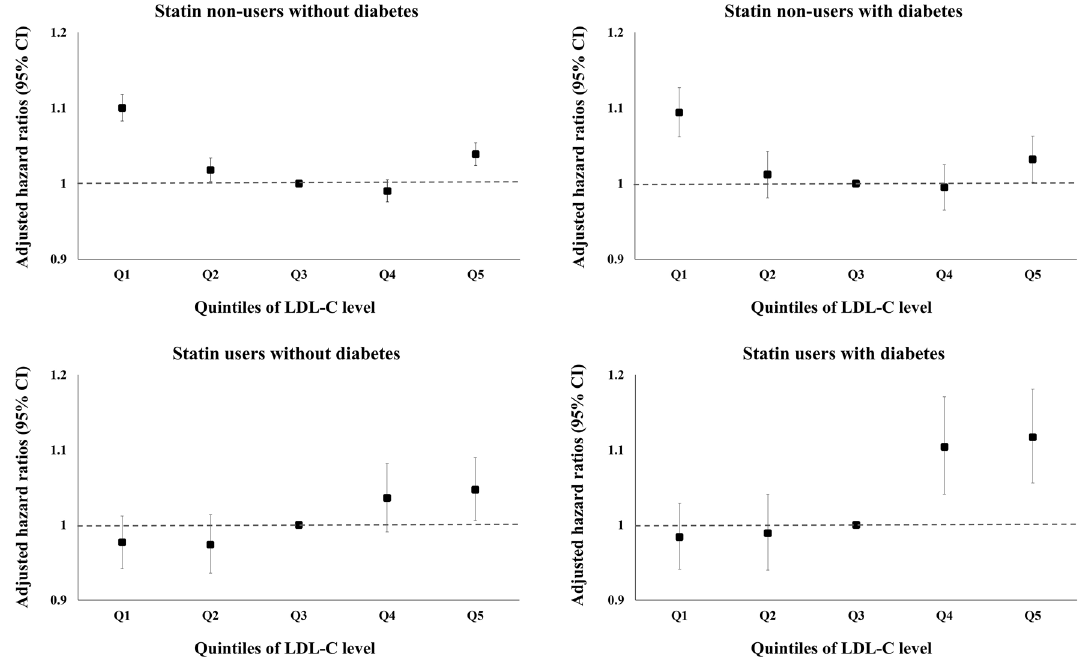
Figure 2. Hazard ratios for the incidence of all-cause dementia according to quintiles of low-density lipoprotein cholesterol levels in groups stratified according to the presence of diabetes and statin use . Adjusted for age, sex, body mass index, hypertension, current smoking status, alcohol consumption status, regular exercise, and estimated glomerular filtration rate. *LDL-C quintile ranges: Q1 (LDL-C < 89 mg/dl), Q2 (89 mg/ dl ≤ LDL-C < 107 mg/dl), Q3 (reference, 107 mg/dl ≤ LDL-C < 124 mg/dl), Q4 (124 mg/dl ≤ LDL-C < 145 mg/dl), Q5 (LDL-C ≥ 145 mg/dl). LDL-C low-density lipoprotein cholesterol, CI confidence